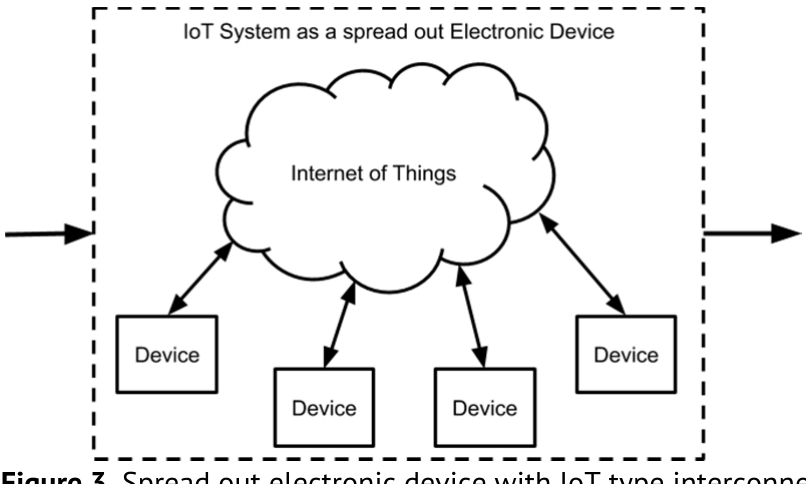
Figure 3. Spread out electronic device with IoT type interconnections.